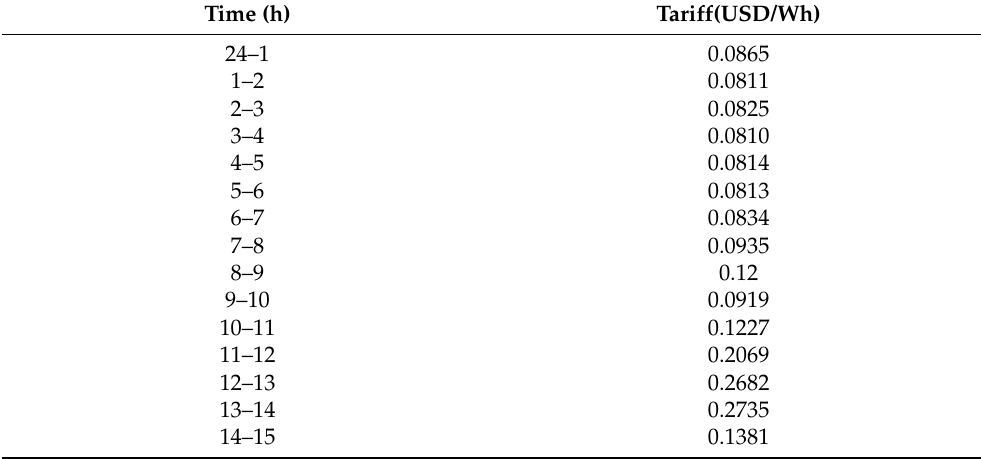
Table 5. Hourly TOU